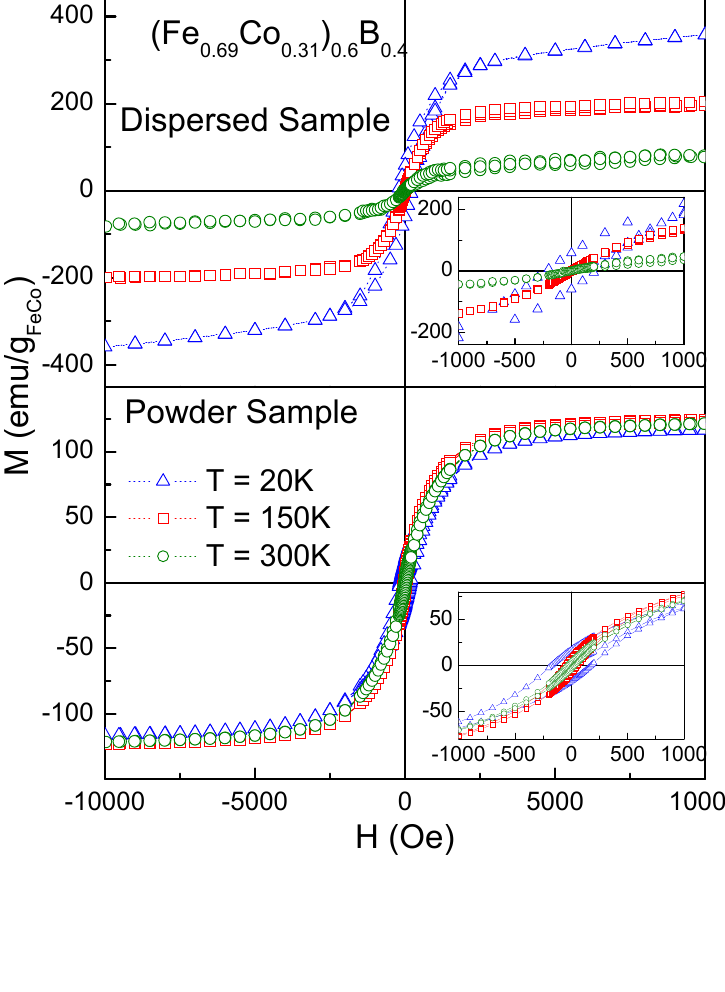
Figure 3. Magnetization loops at different temperatures for (Fe ( a ) and powder ( b ) particles. The insets correspond to the low field magnetization